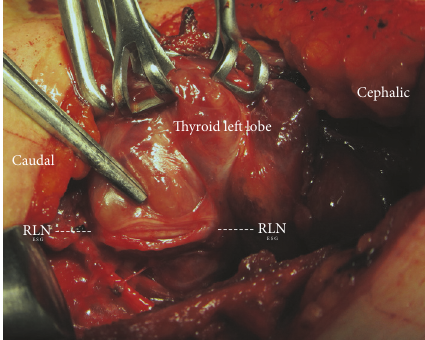
Figure 2: The left recurrent laryngeal nerve (RLN) adherent to the lateral surface of recurrent goiter